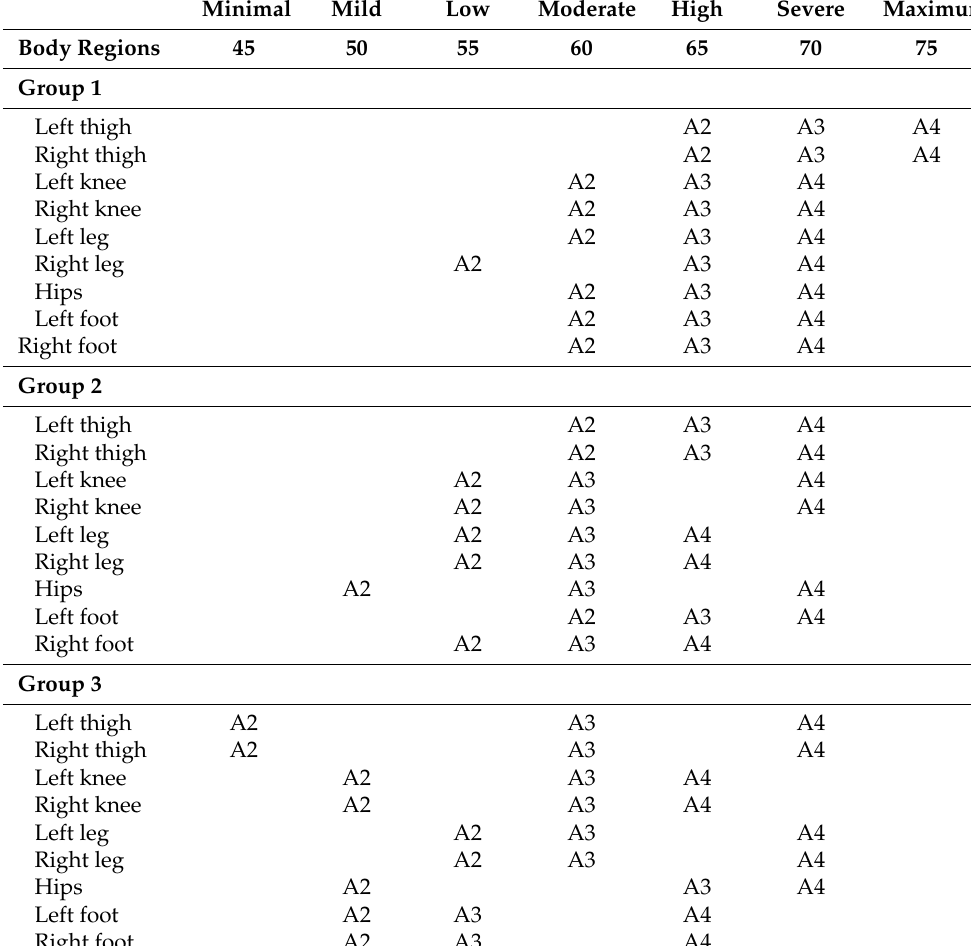
Table 4. Lower limb discomfort